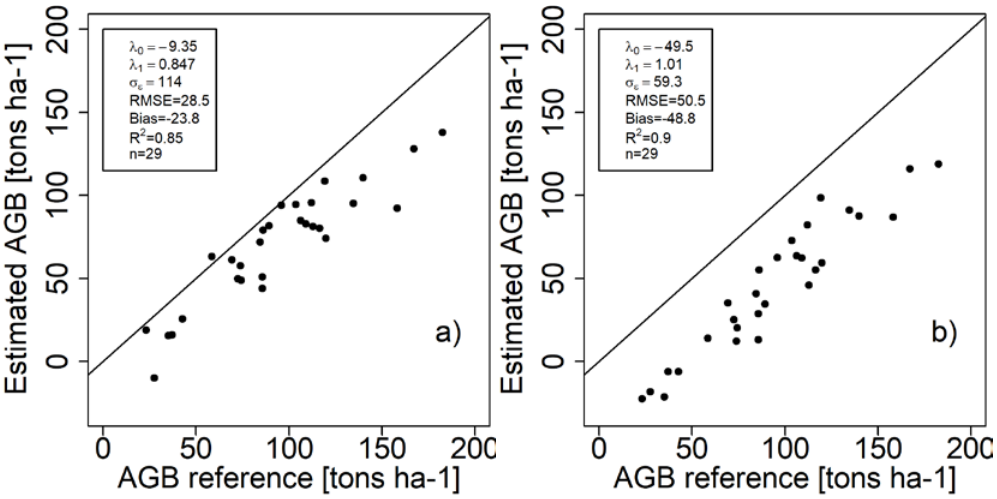
Figure 5. Scatterplots of estimated aboveground biomass (AGB) vs. field reference AGB at the evaluation test site Krycklan. ( a ) TanDEM-X ( b ) ALS.